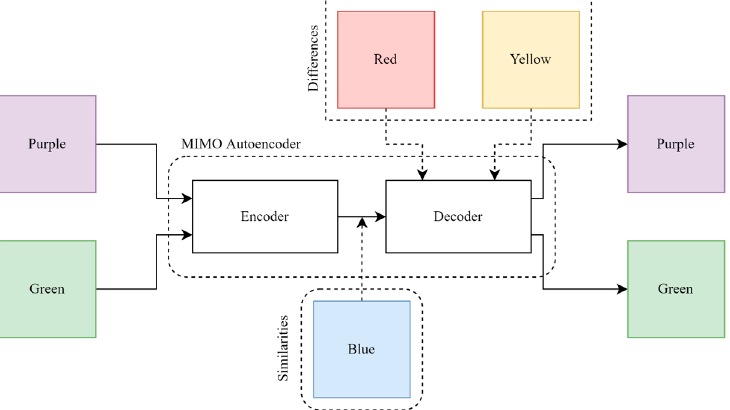
Figure 1. Simple explanation of trained MIMO-AE and relation of inputs and extracted features.